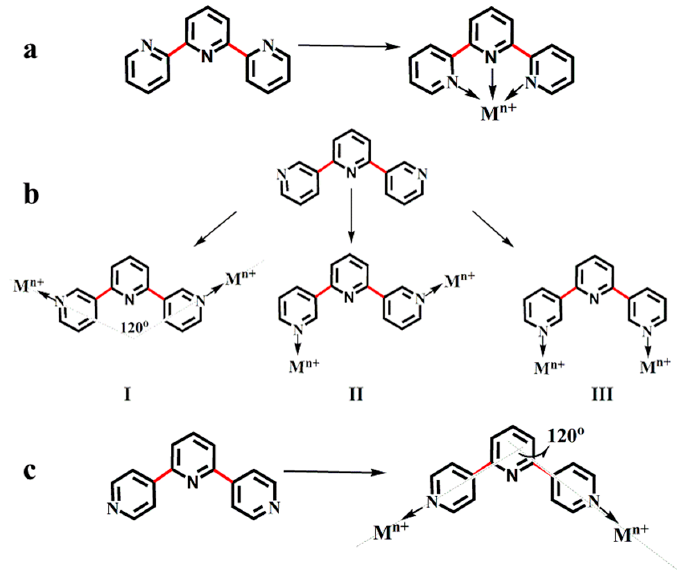
Figure 1. Three types of terpyridine: 2,2 ′ :6 ′ ,2 ′′ -terpyridine. ( a ) 3,2 ′ :6 ′ ,3 ′′ -terpyridine; ( b ) 4,2 ′ :6 ′ ,4 ′′ - terpyridine; ( c ) the directional metal-binding properties of them.